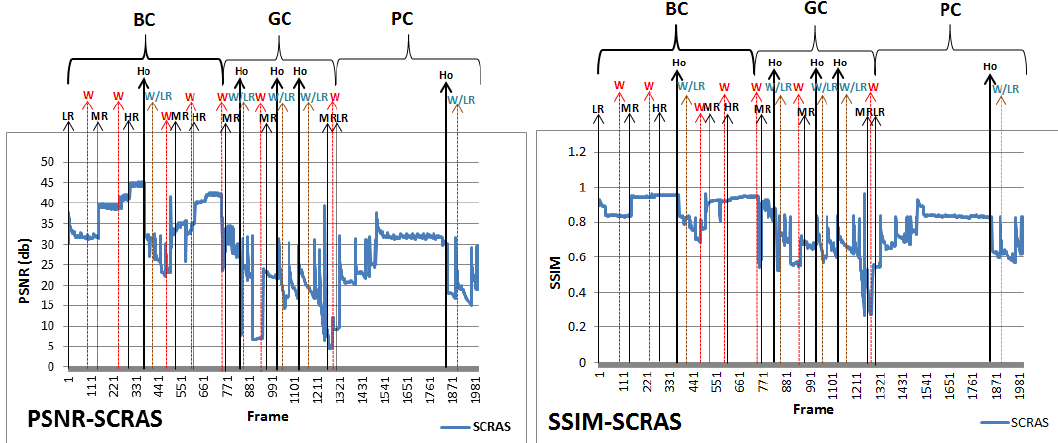
Figure 6. PSNR and SSIM on a fixed flight